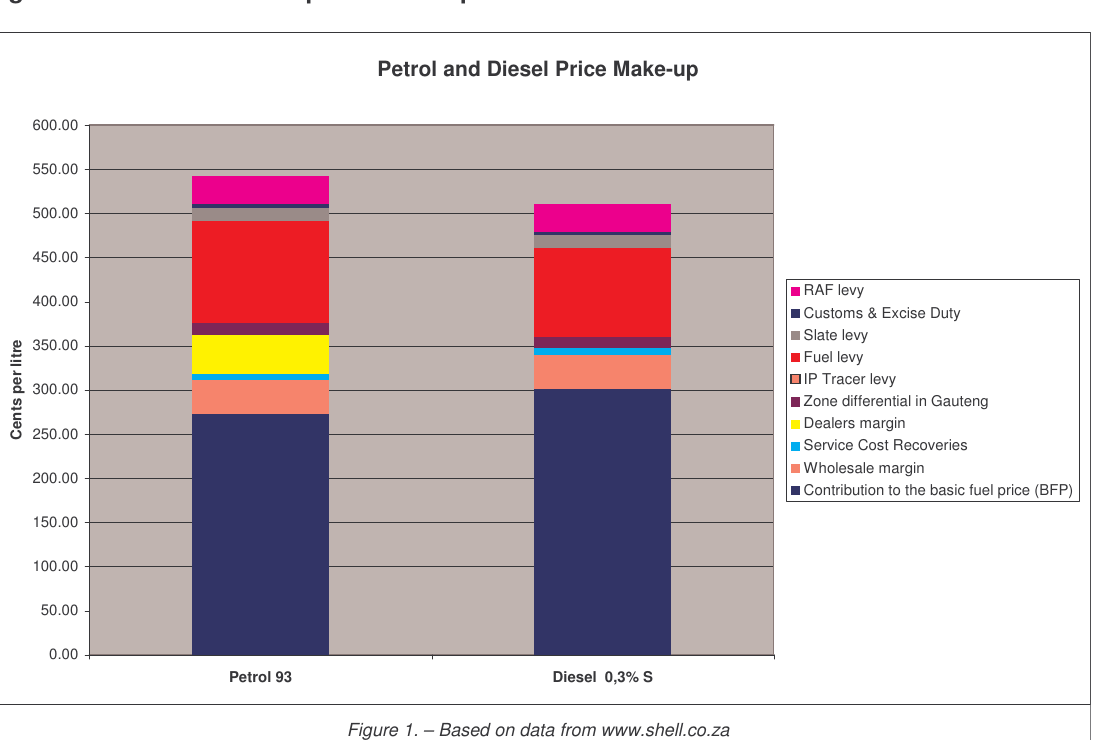
Figure 1. – Based on data from www.shell.co.za